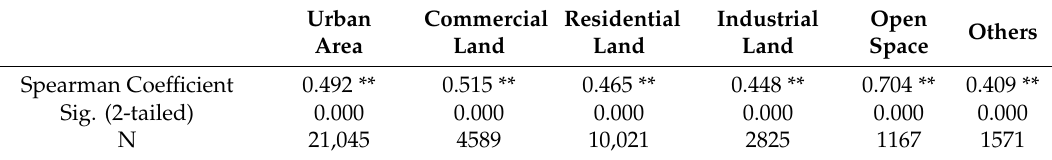
** indicates significance at the 0.01 level. Table 7. Spearman correlations between the GVI and NDVI in the main city and each UFZ.